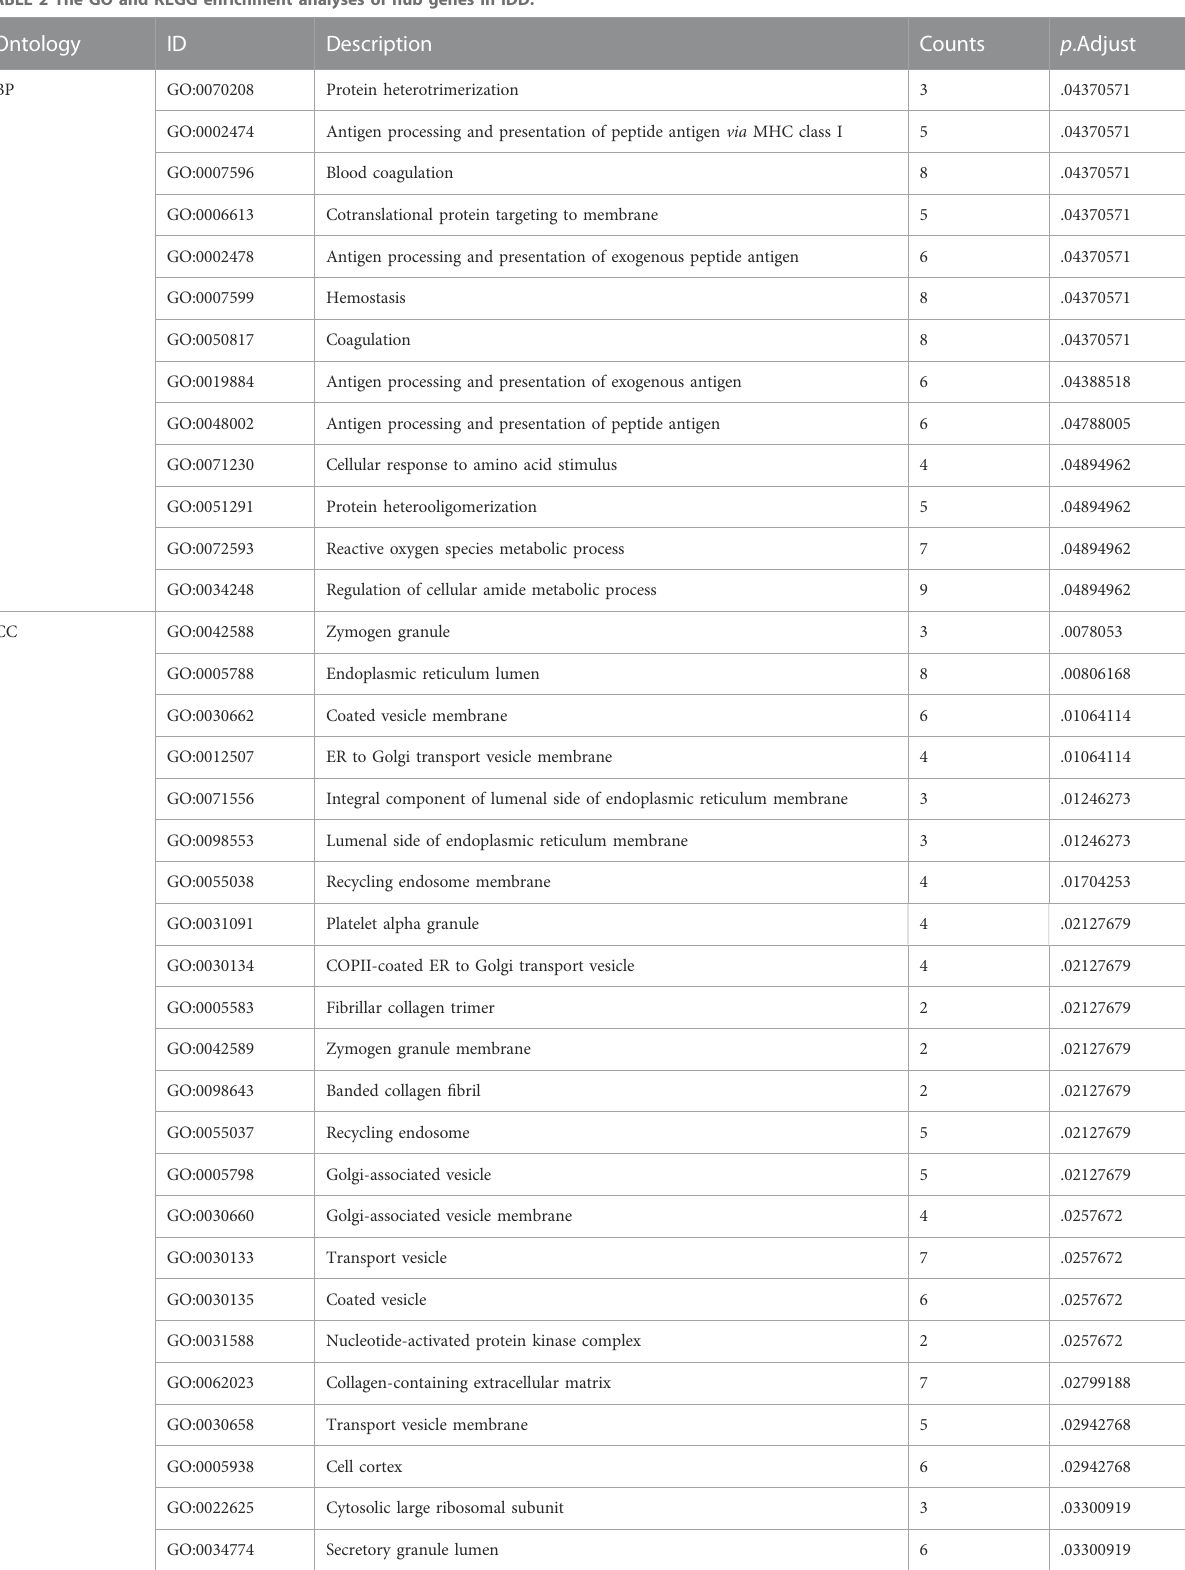
TABLE 2 The GO and KEGG enrichment analyses of hub genes in IDD.